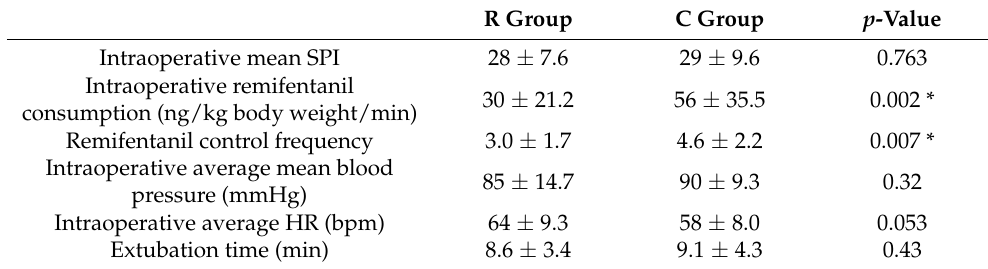
Table 2. Intraoperative SPI-related